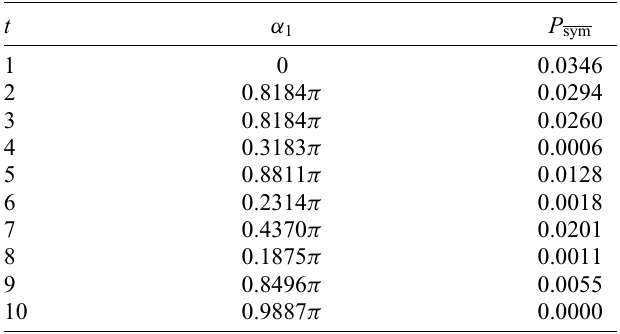
FIG. 10. The population of the symmetry-forbidden subspace as a function of the angles α 1 for t = 2, 4, 8, for μ = 0.1, x = 0.6, N = 4, and δ t = 1. We choose α 1 to be the smallest angle that minimizes P sym at each t .